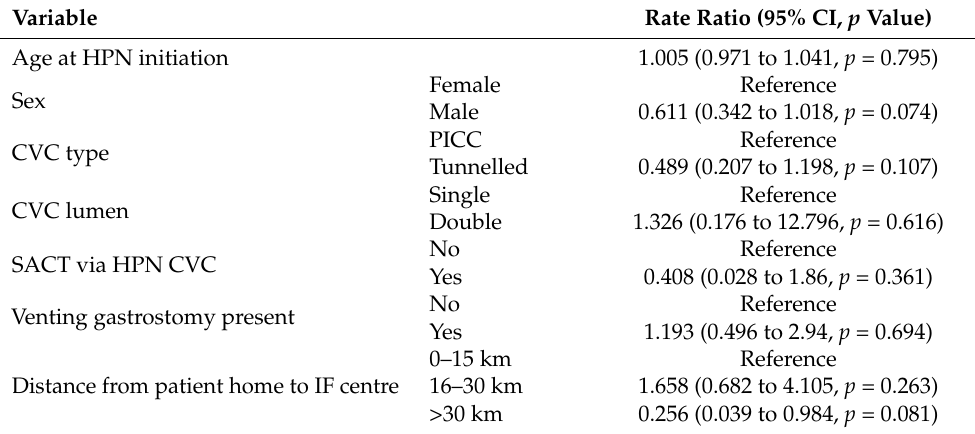
Table 4. Univariate Poisson regression of the factors associated with mechanical CVC complications. SACT, systemic anti-cancer